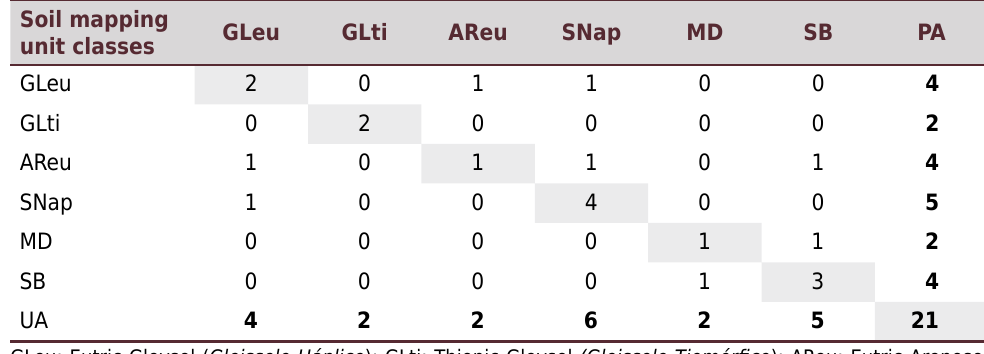
GLeu: Eutric Gleysol ( Gleissolo Háplico ); GLti: Thionic Gleysol (Gleissolo Tiomórfico ); AReu: Eutric Arenosol ( Neossolo Quartzarênico ); Snap: Abruptic Solonetz ( Planossolo Nátrico ); MD: Mobile dunes; SB: Sand beach; UA: User’s accuracy; PA: Producer’s